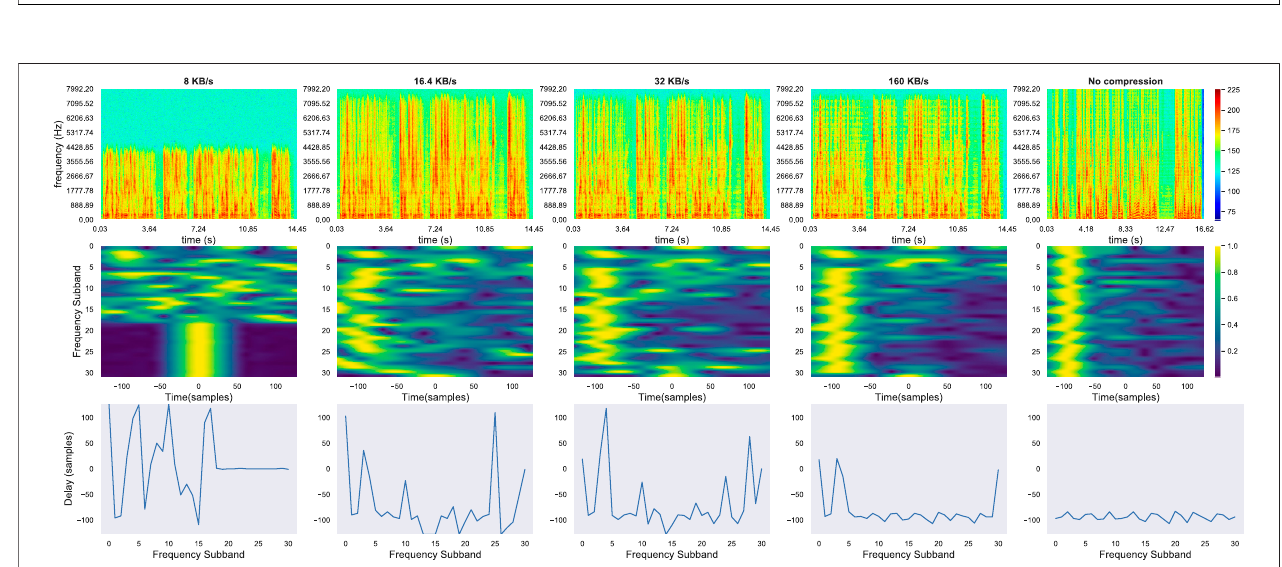
FIGURE 9 | 1 st row: Spectrograms for one uncompressed test utterance channel and its PyAWNeS-encoded versions at various bitrates [8, 16.4, 32, 160]kB/s. 2 nd row: Frequency-slided CPS input feature computed between two segmentsof the encoded channels. 3 rd row: argument ofthe maximum ofCPS in each frequency band corresponding to the delay (samples) between the two channels.